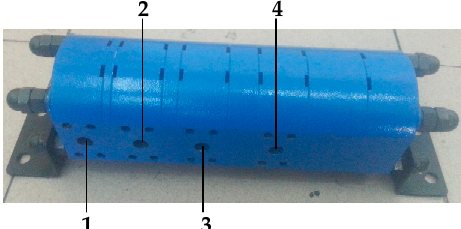
Figure 1. Structure diagram of the flow dividing and collecting system of four gear–pump/motor units. (1) Gear–pump/motor with a displacement of V 0 ; (2) Gear–pump/motor with a displacement of 2 V 0 ; (3) Gear–pump/motor with a displacement of 4 V 0 ; (4) Gear–pump/motor with a displacement of 8 V 0 .